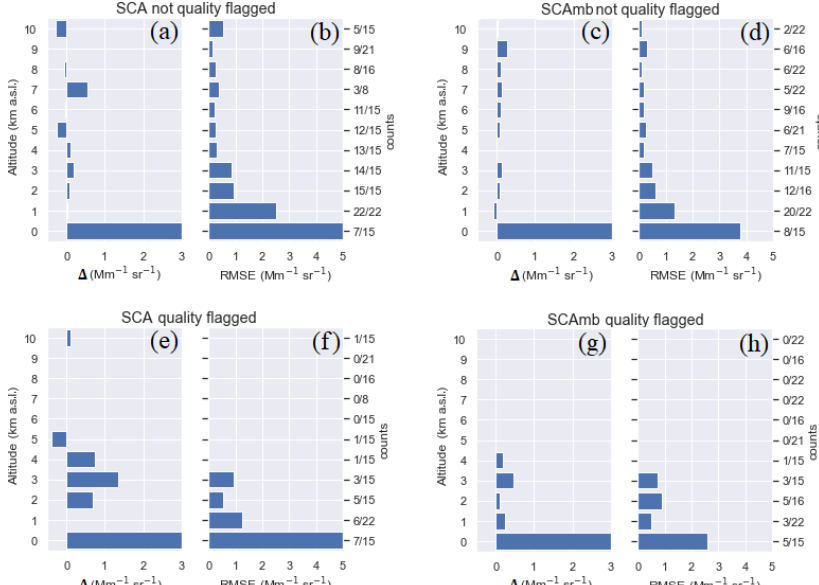
Figure 16. Statistical results for the intercomparison of Aeolus SCA and SCAmb products with Évora ground-based measurements, with and without quality flags. The right-hand axis indicates the number of available data points included in each vertical range out of the total number of measurements within that vertical range. The (a) difference ( (cid:49) ) and (b) RMSE of the intercomparison of the SCA products without quality flags applied. The (c) (cid:49) and (d) RMSE of the intercomparison of the SCAmb products without quality flags applied. Panels (e) and (f) are the same as panels (a) and (b) , respectively, but considering quality flags. Panels (g) and (h) are the same as panels (c) and (d) , respectively, but considering quality